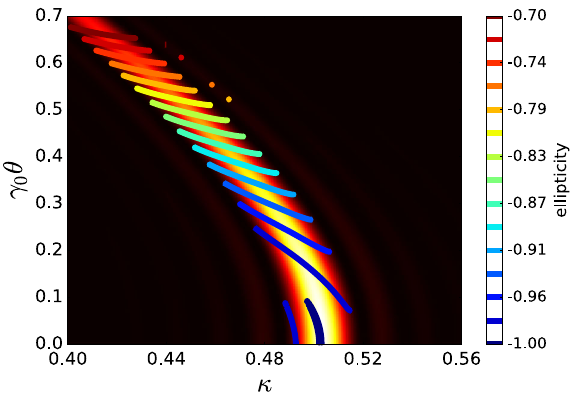
FIG. 7. Photon energy-angular spectrum in arbitrary units as a function of normalized photon energy κ (longitudinal axis) and normalized angle γ 0 θ (vertical axis) for the case of optimally injected electron beam. The colored lines show the corresponding contours of the radiation ellipticity (values indicated in colorbar) as functions of normalized photon energy κ and angle γ 0 θ